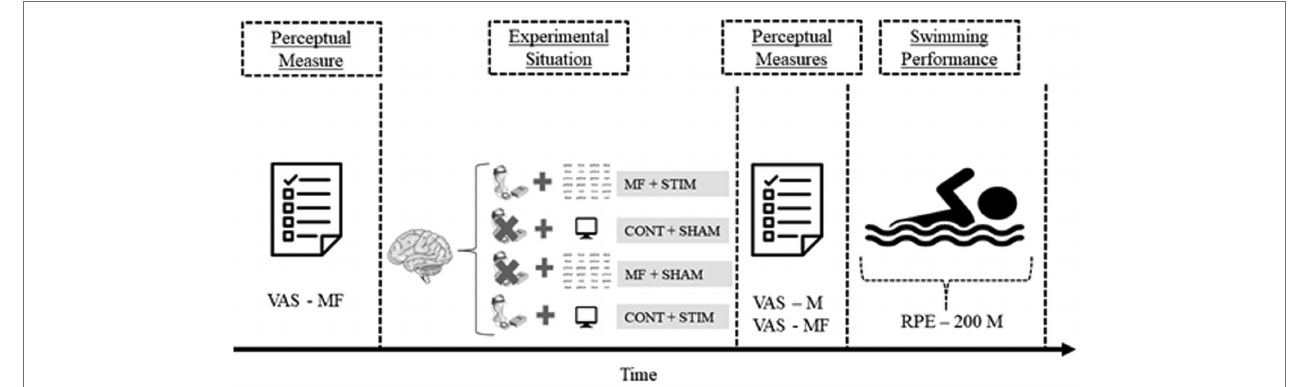
FIGURE 1 | Experimental design. CONT + BS, control procedure plus brain stimulation; CONT + SHAM, control procedure plus SHAM stimulation; MF + BS, mental fatigue plus brain stimulation; MF + SHAM, mental fatigue plus SHAM stimulation; RPE, rating of perceived exertion; VAS – M, visual analog scale for motivation; and VAS – MF, visual analog scale for mental